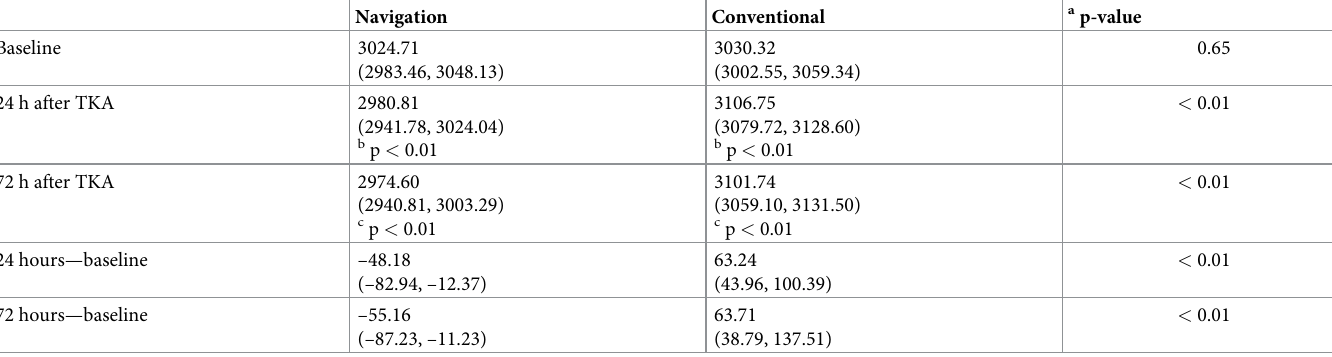
Table 5. Serum TGF- β 1 concentrations (pg/mL) prior to TKA,then at 24 and 72 hours after TKA.